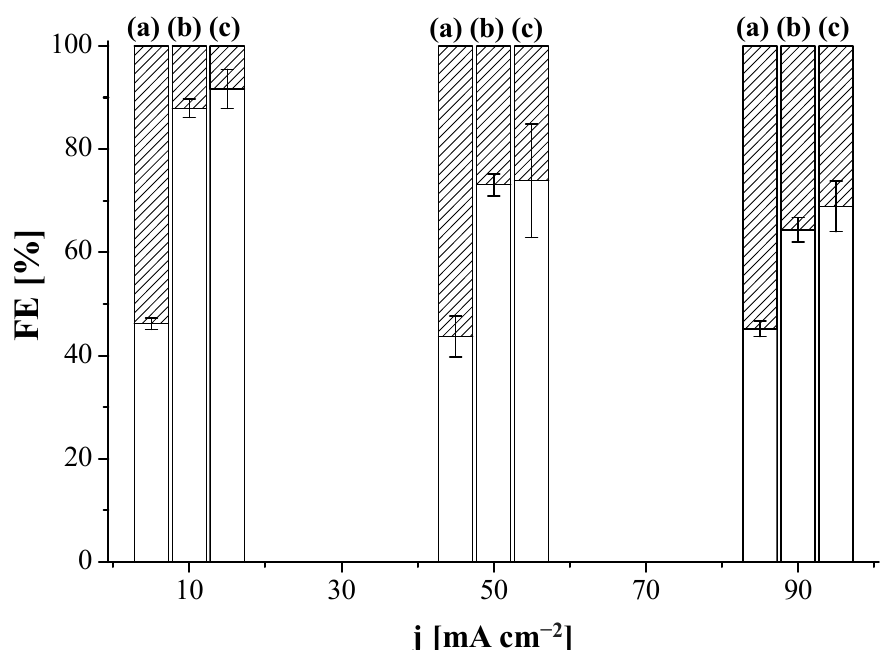
Figure 2. Faradaic efficiency (FE) of ethylene (blank) and hydrogen (striped) as a function of applied current density for the Fumatech MEA (FAA-3 AEM and Cu:Fumion GDE) (a), Sustainion MEA (Sustainion membrane and Cu:Sustainion GDE) (b) and the MEA composed by the Sustainion membrane and the Cu:CS GDE (c).